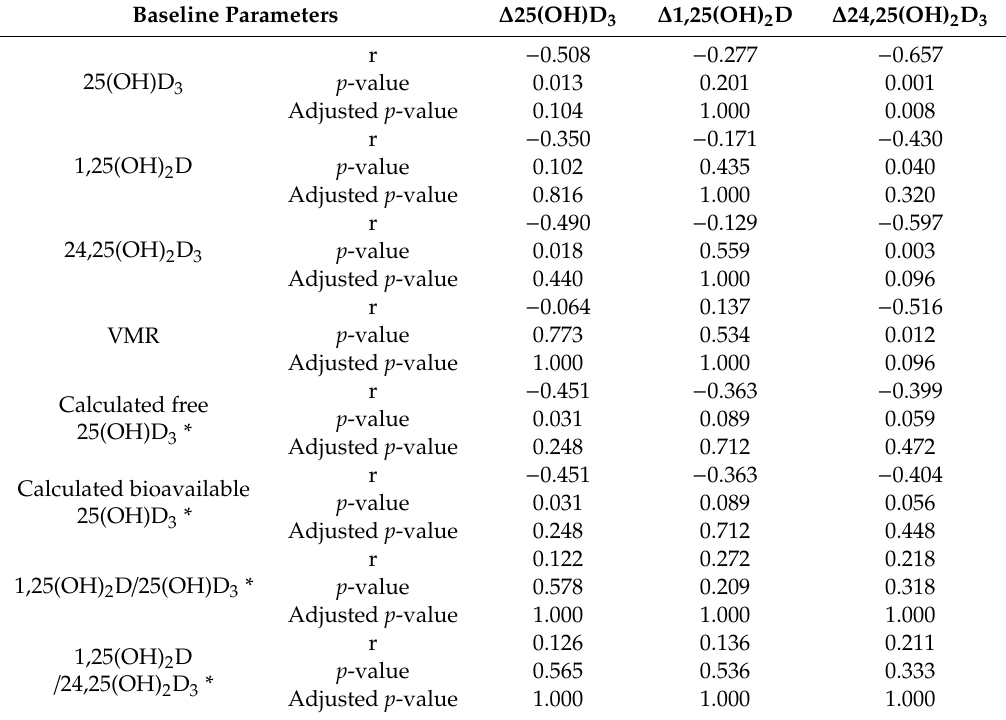
Table A1. Pearson correlations of baseline vitamin-D-related parameters adjusted for gender, age, BMI, PTH, eGFR, serum phosphate and serum calcium, with the changes from baseline of 25(OH)D, 1,25(OH) 2 D and 24,25(OH) 2 D after vitamin D supplementation. p -values without and with Bonferroni adjustment are